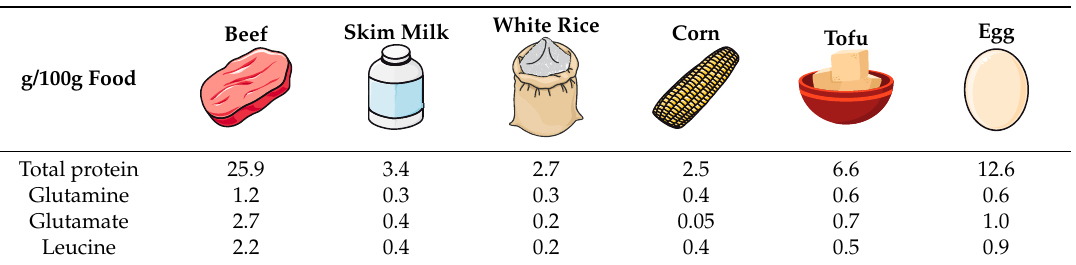
Table 1. Total protein, glutamine, glutamate, and leucine (g/100g food) content in some animal and vegetable foods using the gene sequencing method (adapted from [166]).